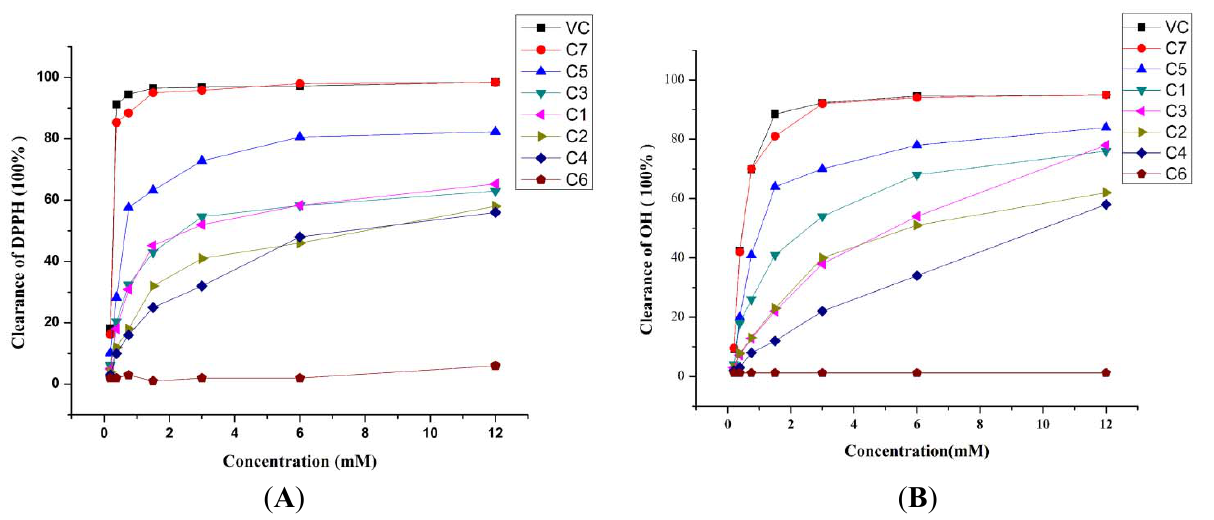
values for DPPH and OH· clearance of hydroxyl-substituted chalcones. 50